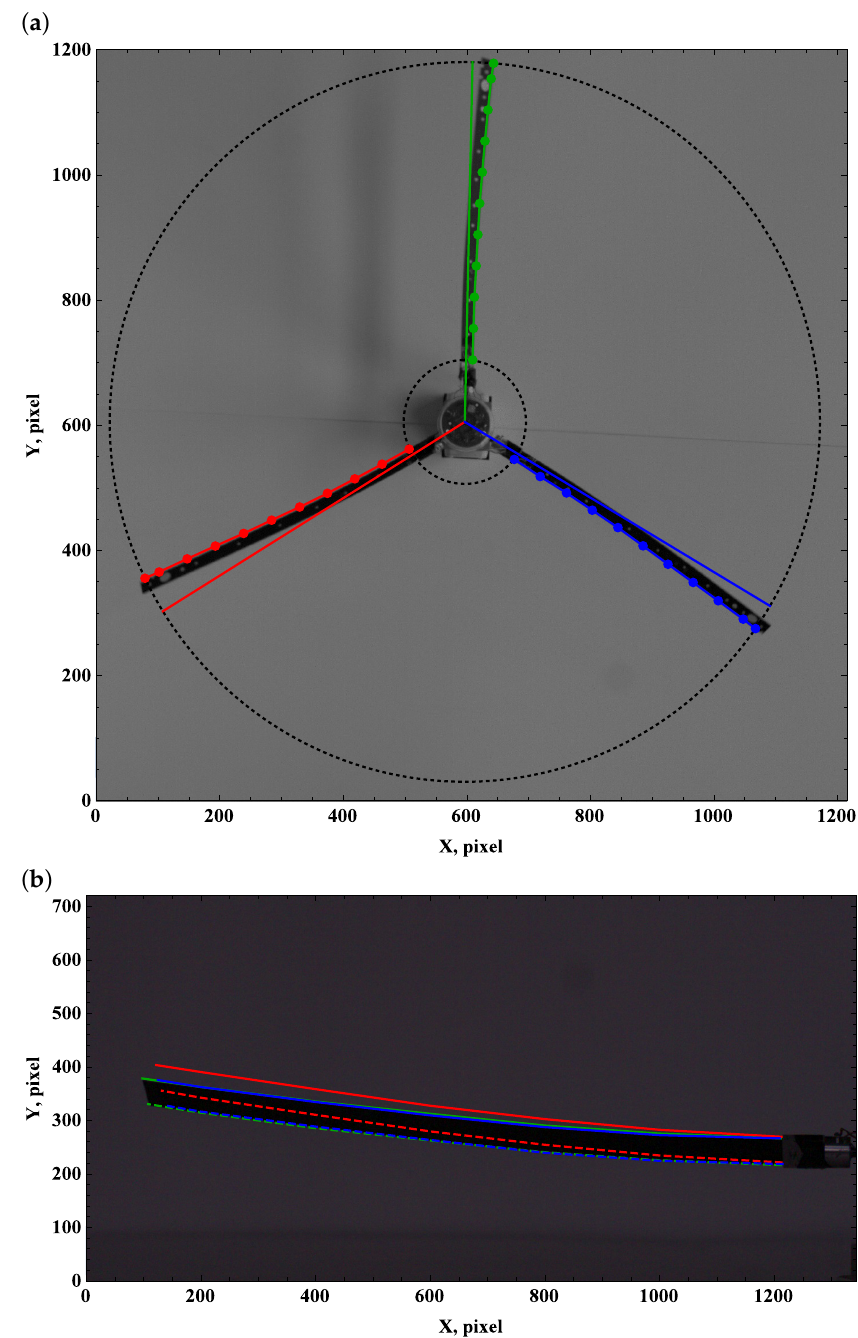
Figure 10. Preset angle 45 ◦ , angular speed 100 rpm: top view ( a ), side view ( b ). The side view frames are labeled with three curvilinear lines describing the deforma- tion of the beam at a given moment. It requires comment. These side view pictures were not taken at the maximum amplitude of the swing out of rotor plane, but they were taken randomly. Capturing an image of the maximum vibration amplitude in a given plane is very demanding, beyond the capabilities of the equipment used. The situation would be different with a camera following the rotor and recording the full movement of the blade, which, of course, generates many more technical